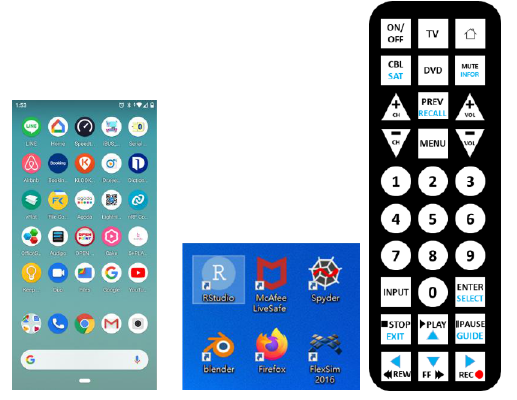
Android smartphone. On the center are square widgets in the Windows system. They appear to have arbitrary shapes until indicated by the mouse cursor. Finally, on the right is a universal remote controller with buttons of equal height and width in real